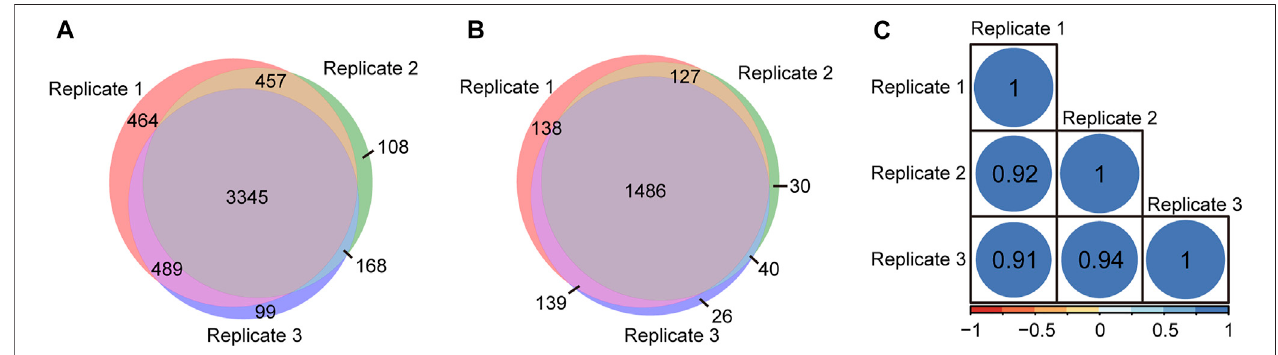
FIGURE 6 | Phosphosites and phosphoproteins identi fi ed from three replicates of tandem enrichment. (A) Identi fi cation reproducibility of phosphosites. (B) Identi fi cation reproducibility of phosphoproteins. (C) Quanti fi cation reproducibility of phosphosites.